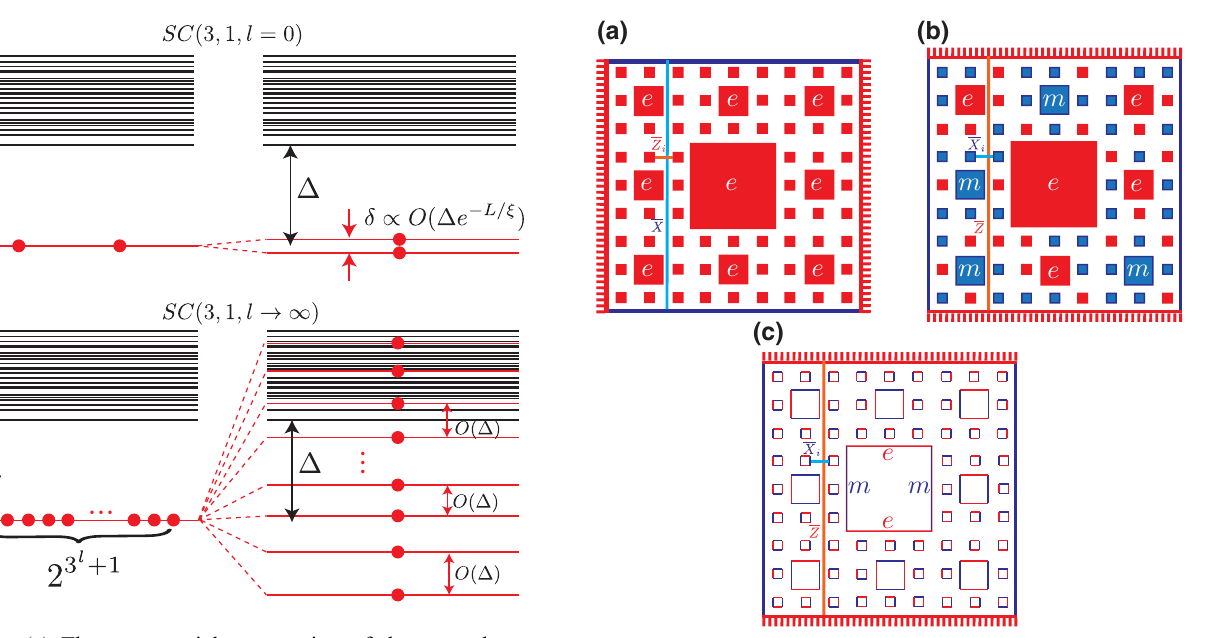
FIG. 7. (a)–(c) Three fractal models with only e -holes, both e - and m -holes, and holes with alternating e - and m -boundaries, respectively. In all three cases, a macroscopic logical string X or Z is intersected by a short dual logical string with O ( 1 ) length, leading to an O ( 1 ) code